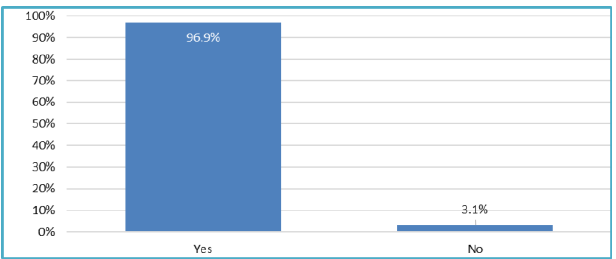
Figure 1 : The distribution of the study population according to their practice of self-medication Table 2 : Distribution of drug practice by study population